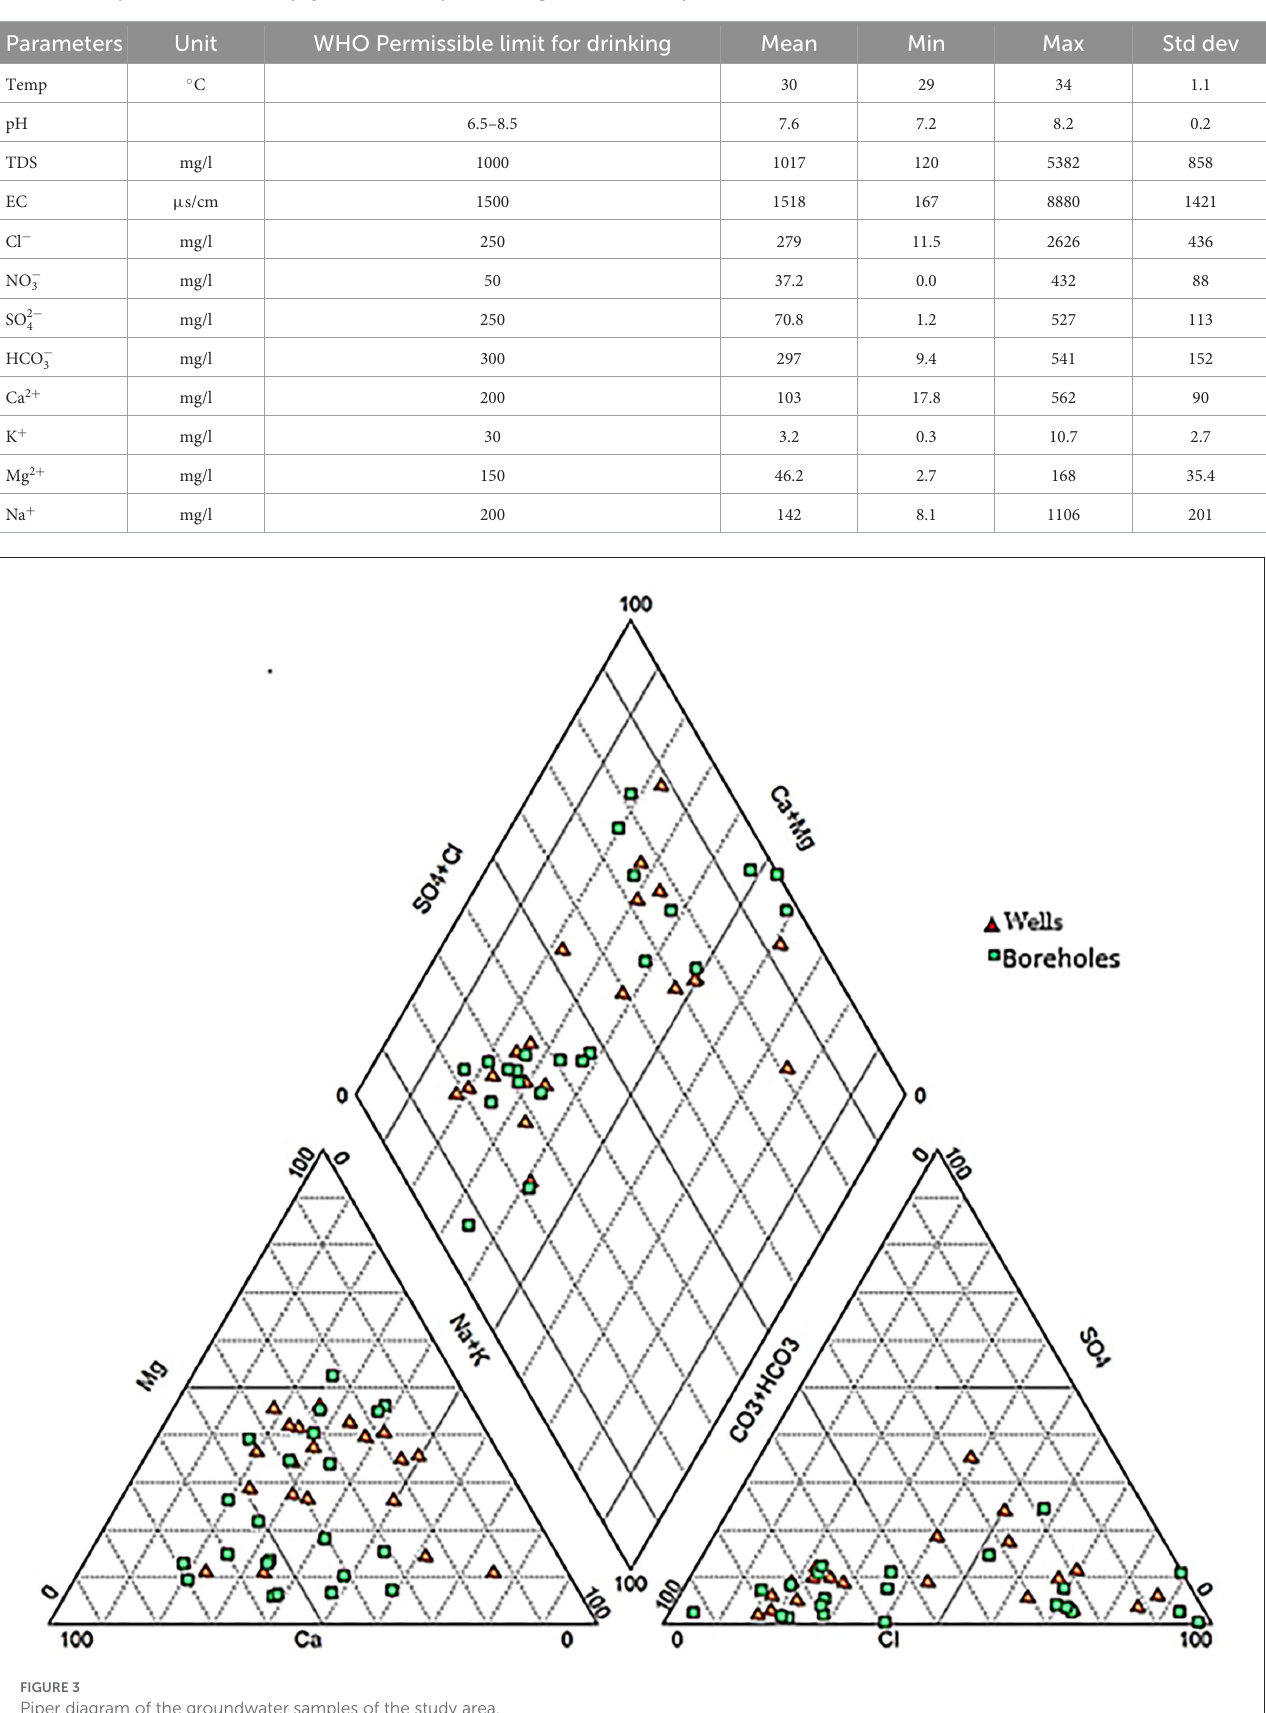
TABLE 2 Descriptive statistics of the physico-chemical parameters groundwater samples.